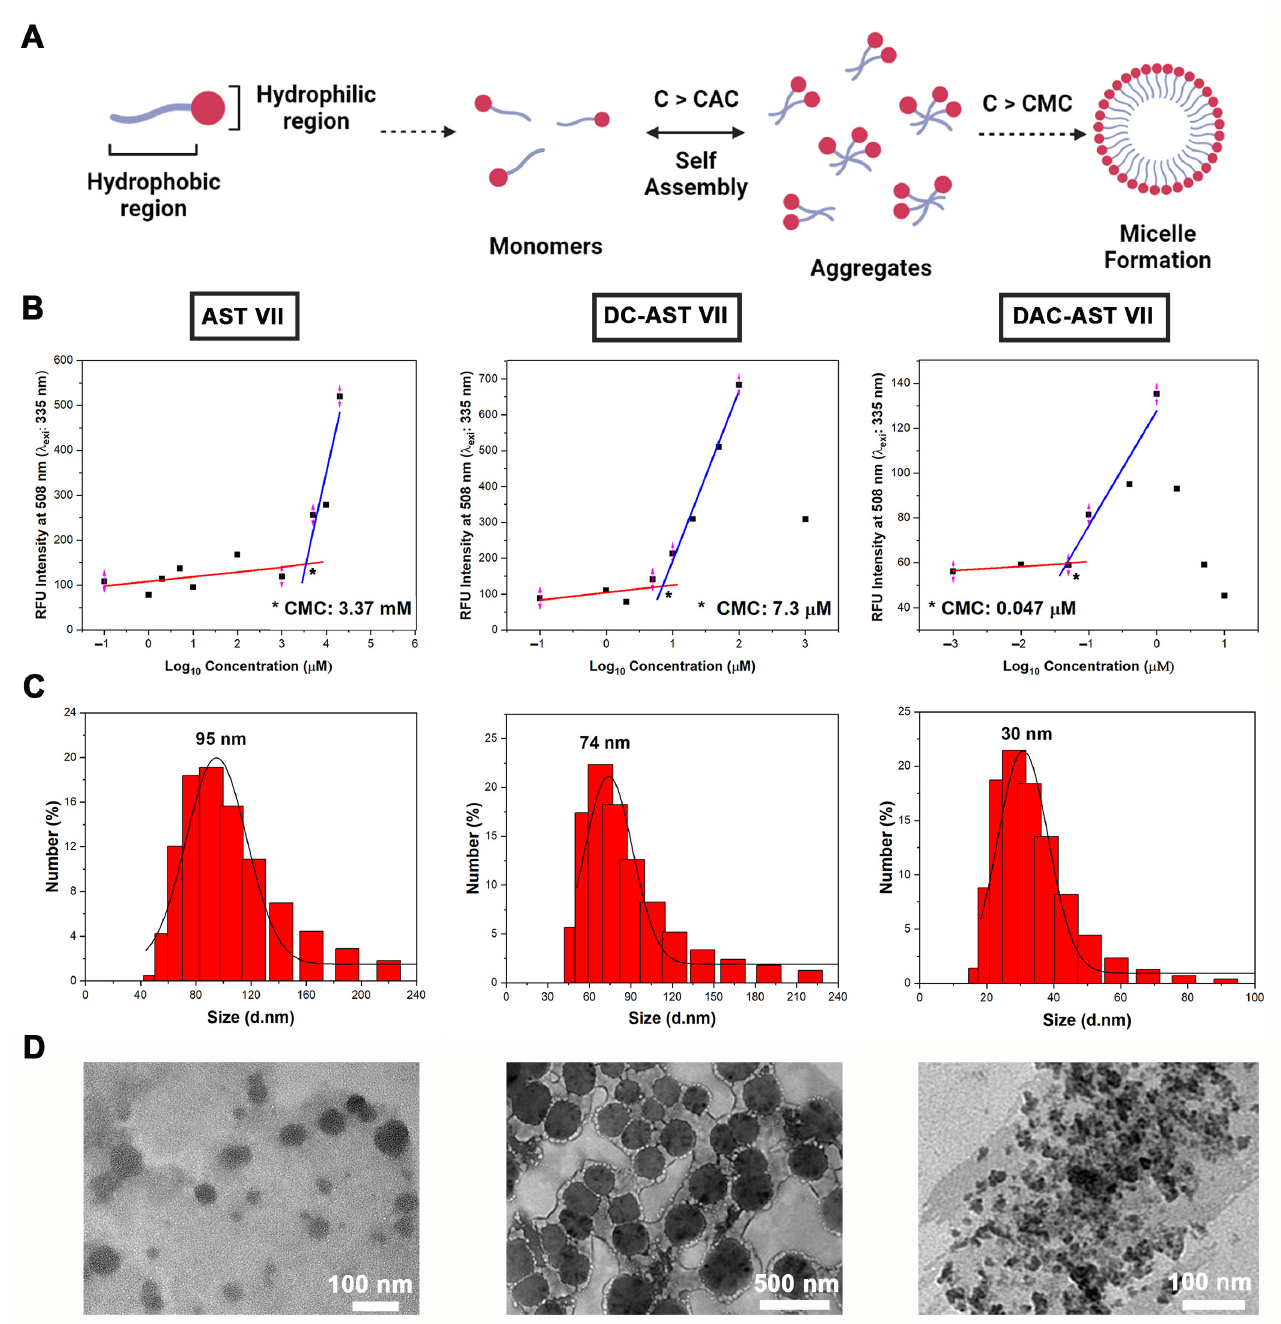
Figure 6. Self-assembling nanoparticles based on Astragalus saponins. ( A ) A general illustration for self-assembling particle formation. C: Concentration, CAC: Critical aggregation concentration, CMC: Critical micelle concentration. ( B ) Relative fluorescence intensity at 508 nm vs. logarithm of Astragalus saponins concentrations to determine CMC. ( C ) Representative particle size distribution of self-assembling Astragalus saponins that were measured using dynamic light scattering (DLS) analysis. ( D ) Transmission electron microscopy (TEM) images of self-assembled nanoparticles based on AST VII (4000 μ M), DC-AST VII (10 μ M), and DAC-AST VII (10 μ M) in dH 2 O. Data represent two or three independent experiments. Created with BioRender.com. *: the intersection of two linear lines, showing CMC value.